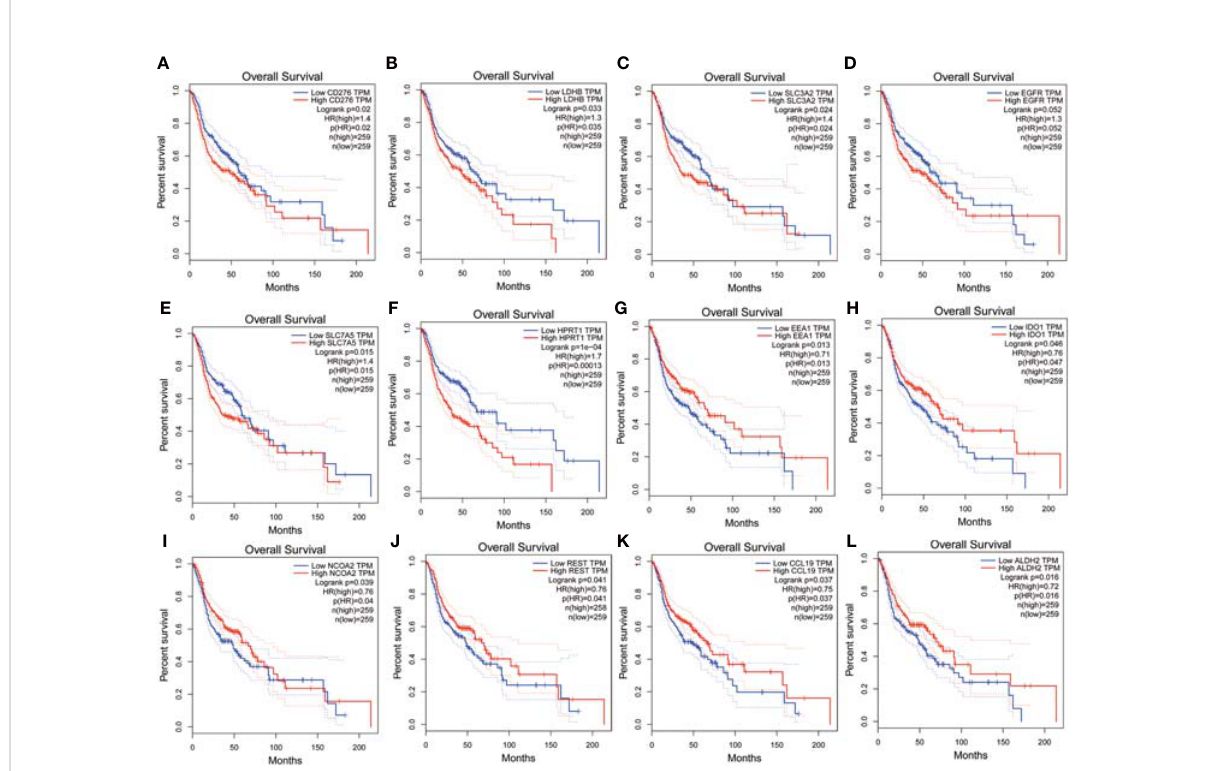
FIGURE 7 Analysis of overall survival of altered genes in nCounter ® Metabolic Pathways Panel in TCGA HNSCC database. (A-F) Analysis of altered genes in Metabolic Pathways Panel with unfavorable prognosis in TCGA HNSCC database. (G-L) Analysis of genes in Metabolic Pathways Panel with favorable prognosis in TCGA HNSCC